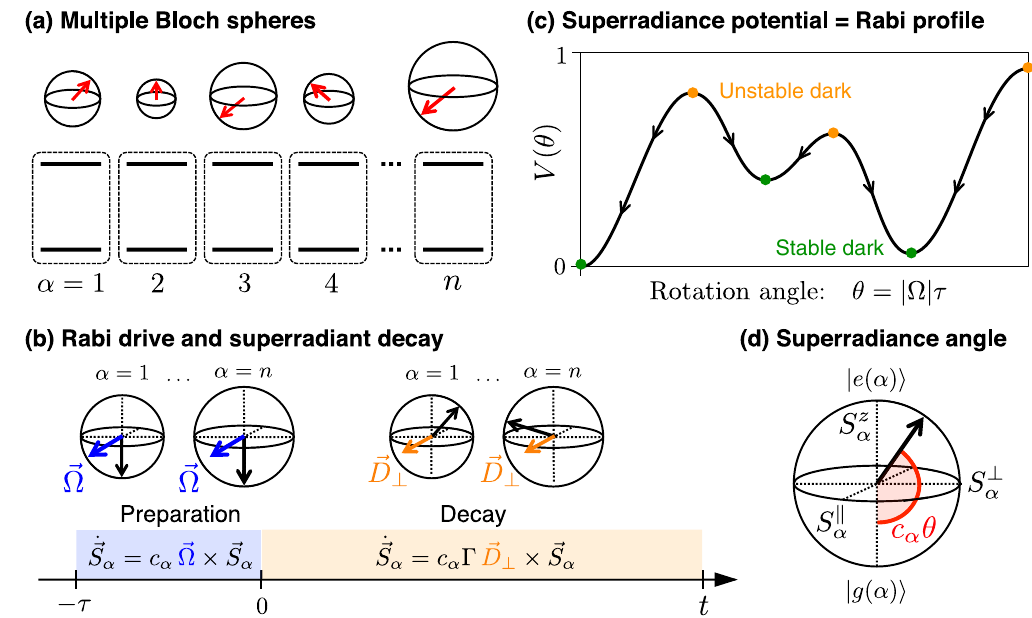
ˆ D (cid:2) FIG. 6. Single-polarization MF analysis. (a) In the appropriate basis, the dipole operator couples the levels in distinct f g ð α Þ ; e ð α Þg pairs [see Eq. (24)], and the system can be described in mean field in terms of multiple Bloch spheres. We show an example where the Bloch sphere of each pair of states α has a different radius s α . (b) We depict the excitation-decay scenario where the atoms start in some ground state j ˜ g i , are excited with the Rabi Hamiltonian of Eq. (27) for a time τ , and are then let to collectively decay with Eq. (23). In ⃗ Ω ⃗ D these two phases, the α -Bloch vectors rotate around the torque vectors and Γ ⊥ , respectively, following the mean-field Eqs. (28) and (29). (c) Pictorial representation of a superradiant potential V ð θ Þ as a function of the angular variable θ . Maxima (orange) correspond to unstable MF dark states and minima (green) are stable MF dark states (or ground states). The slope of the potential determines the direction in which θ evolves in time [Eq. (35)], as indicated by the arrows. Note that the shape of V ð θ Þ depends on the choice of j ˜ g i . (d) The superradiant decay dynamics of the multiple Bloch spheres can be described in mean field by a single angular variable θ ð t Þ . The ⃗ D θ ð t Þ . The spin component S k α parallel to ⃗ D dynamics happens in the ð S z α ; S ⊥ α Þ plane perpendicular to ⊥ , where the polar angle is c α ⊥ stays